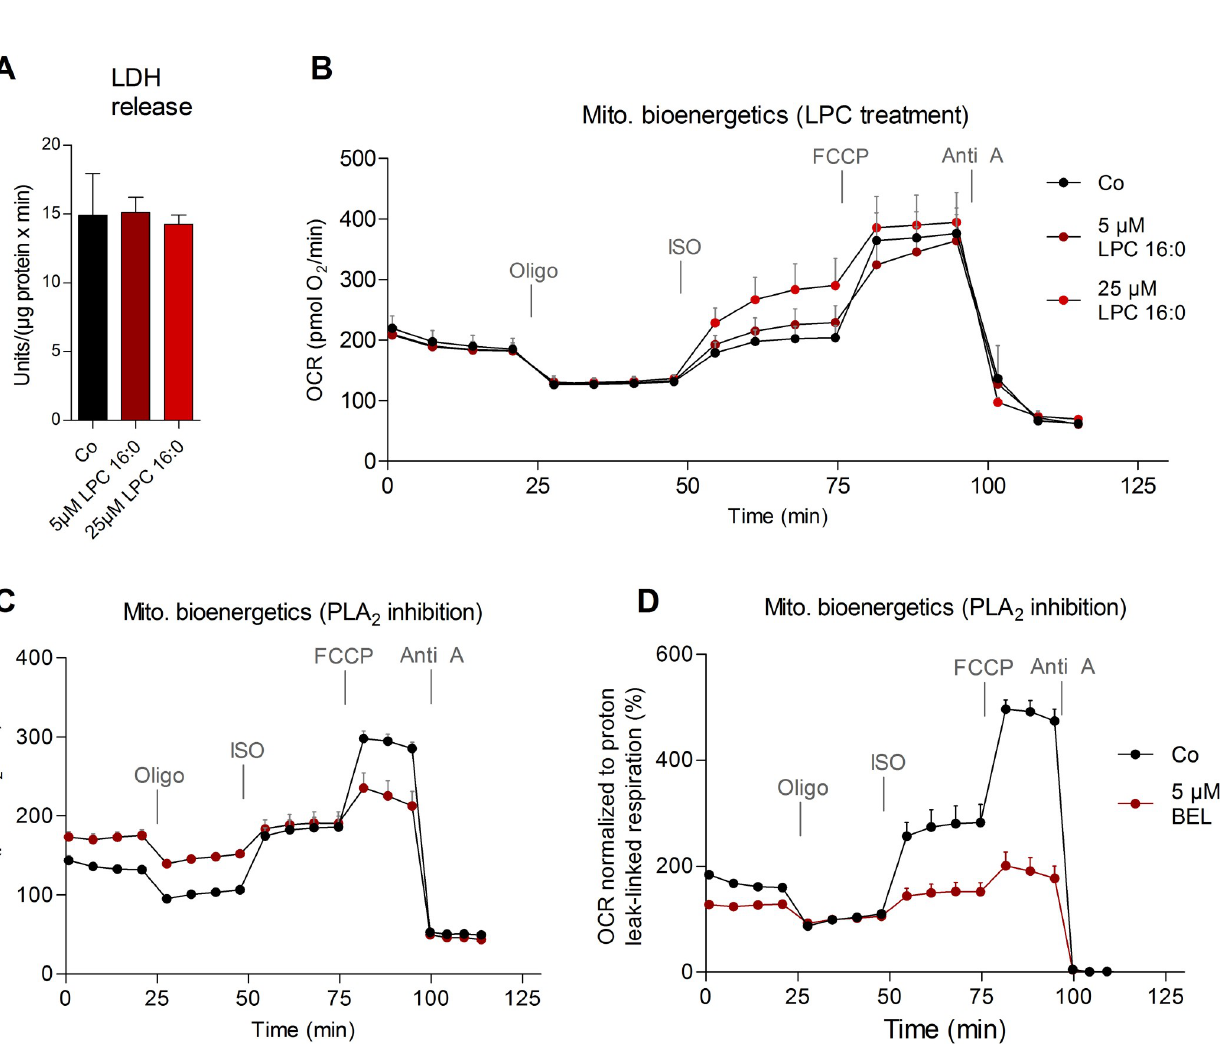
Fig 6. Mitochondrial bioenergetics in brown adipocytes after treatment with LPC 16:0 or BEL. (A) LDH release after stimulation with 5 μ M and 25 μ M LPC 16:0 for 1 hour. Shown are means ± SD of triplicates with AT pooled from 3 mice. (B) Mitochondrial bioenergetics profile (OCR in pmol O 2 /min), including basal respiration, basal leak respiration, UCP1-mediated leak respiration, maximal oxygen consumption, and nonmitochondrial respiration of primary brown adipocytes after stimulation with 5 μ M and 25 μ M LPC 16:0 for 1 h. Shown are means ± SEM of n = 7 (Co, 5 μ M LPC) and n = 8 (25 μ M LPC) with AT pooled from 3 mice. Mitochondrial bioenergetics—(C) OCR shown in pmol O 2 /min and (D) OCR baselined to basal leak respiration—of brown adipocytes pretreated with 5 μ M BEL for 1 hour. Shown are means ± SEM of n = 14 (Co) and n = 13 (BEL) with AT pooled from n = 3 mice. The underlying data of (A–D) can be found in S1 Data. Anti A, antimycin A; AT, adipose tissue; BEL, bromoenollactone; Co, control; FCCP, carbonyl cyanide 4- (trifluoromethoxy) phenylhydrazone; ISO, isoproterenol; LDH, lactate dehydrogenase; LPC, lyso-PC; Mito,; OCR, oxygen consumption rate;